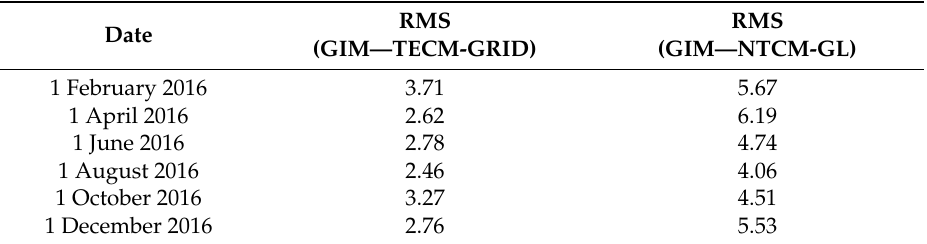
Figure 13. Comparison of TECM-GRID and NTCM-GL with the CODE GIM (1 December 2016). Table 2. RMS Statistics and Optimal Model Evaluation of difference between CODE GIM and TECM-GRID.